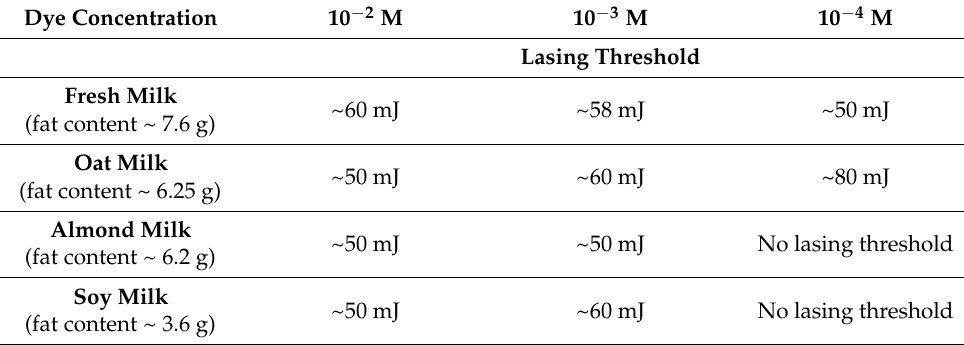
Table 2. Lasing threshold of random lasers based on different types of milk with various dye con- centrations.